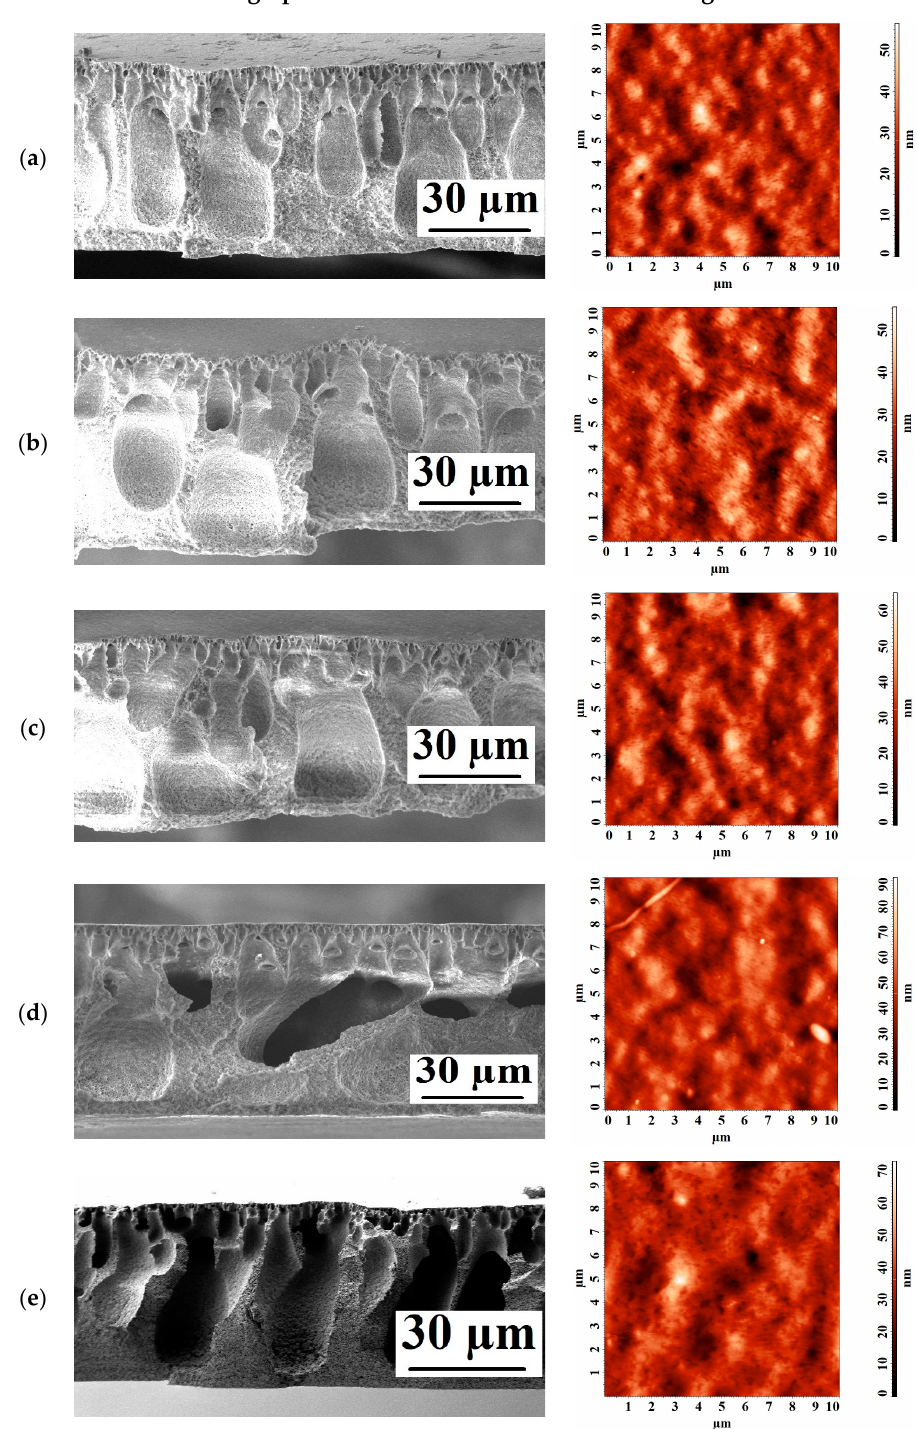
Figure 5. SEM micrographs of the cross section and AFM images of the surface of the developed porous membranes: ( a ) PVDF porous , ( b ) PVDF+TiO 2 (0.3%) porous , ( c ) PVDF+GO-TiO 2 (0.3%) porous , ( d ) PVDF+MWCNT/TiO 2 (0.3%) porous , and ( e ) PVDF+Ag-TiO 2 (0.3%) porous